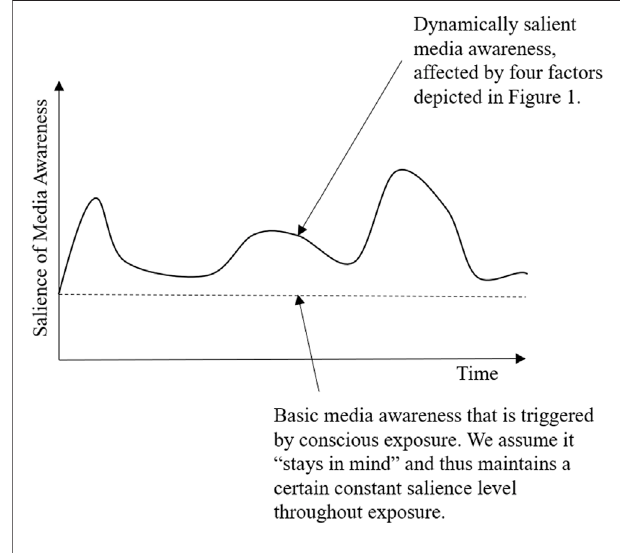
FIGURE 2 | Development of media awareness over time throughout exposure. Conscious media exposure activates a basic constant level of media awareness. During media exposure, several factors (introduced in Figure 1 ) in fl uence the dynamically salient part of media awareness. We assume media awareness never drops below baseline levels,